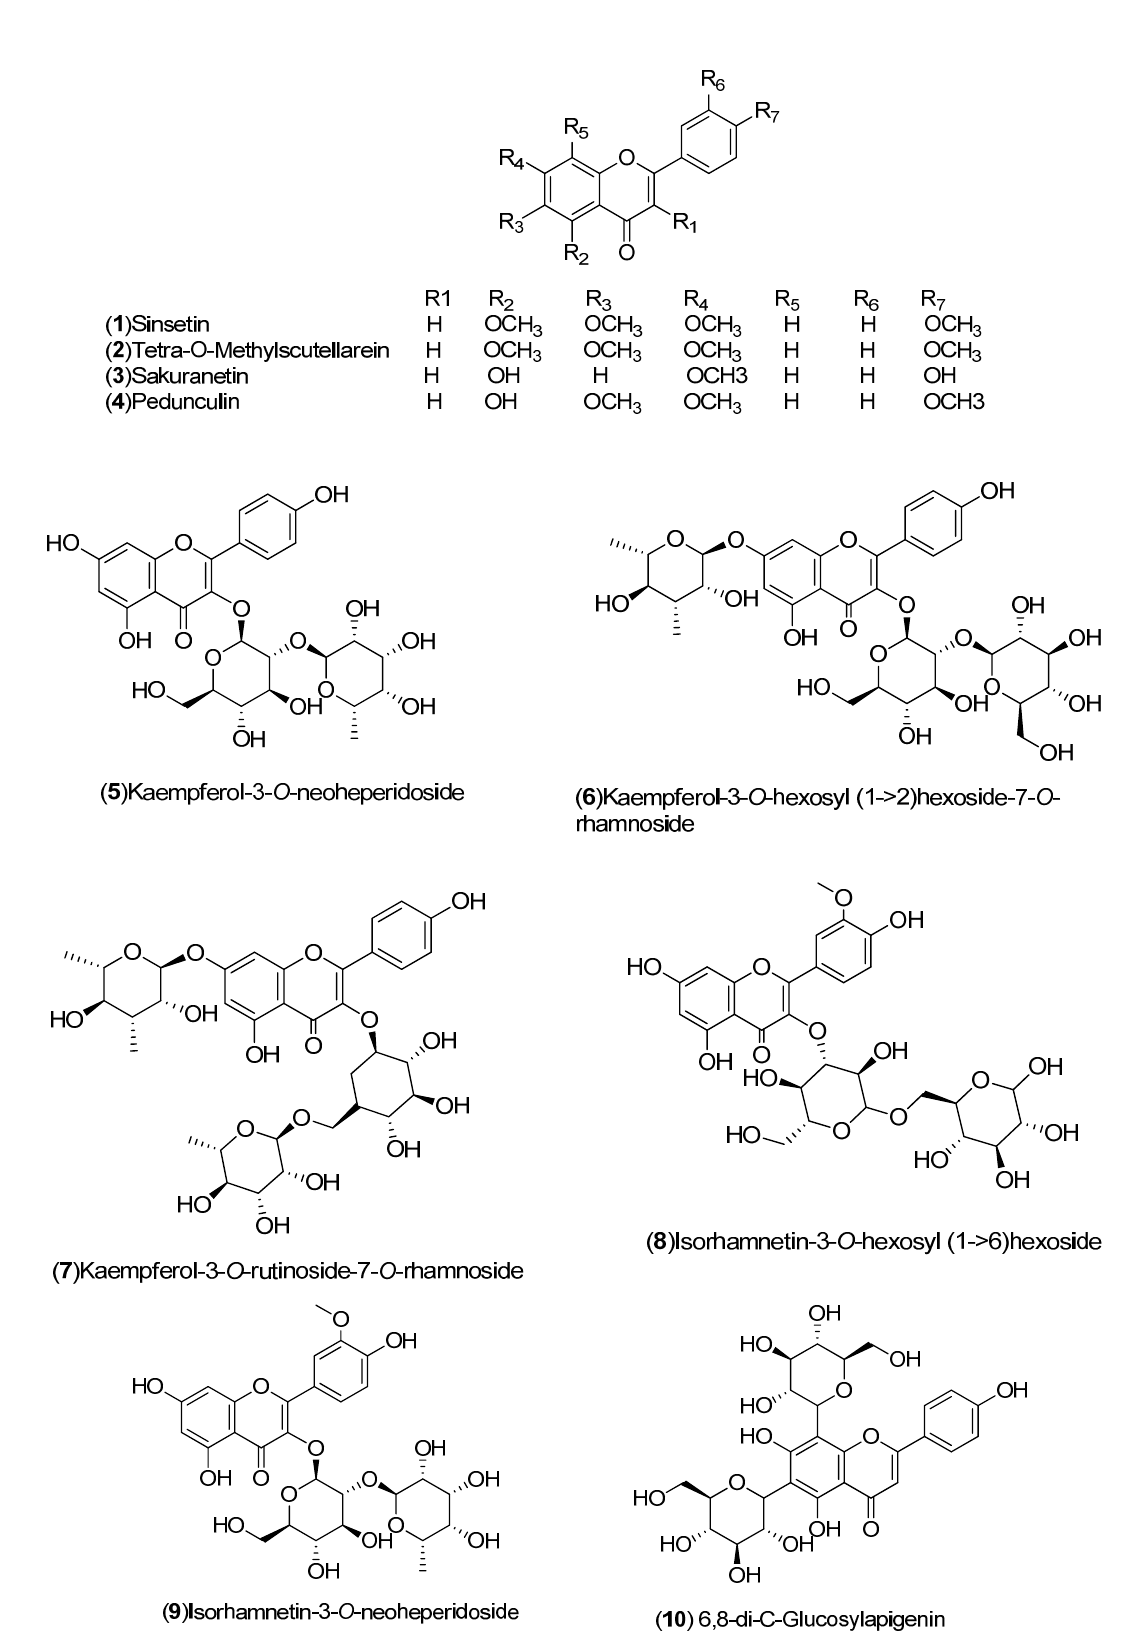
Figure 1. Cont. Figure 1.